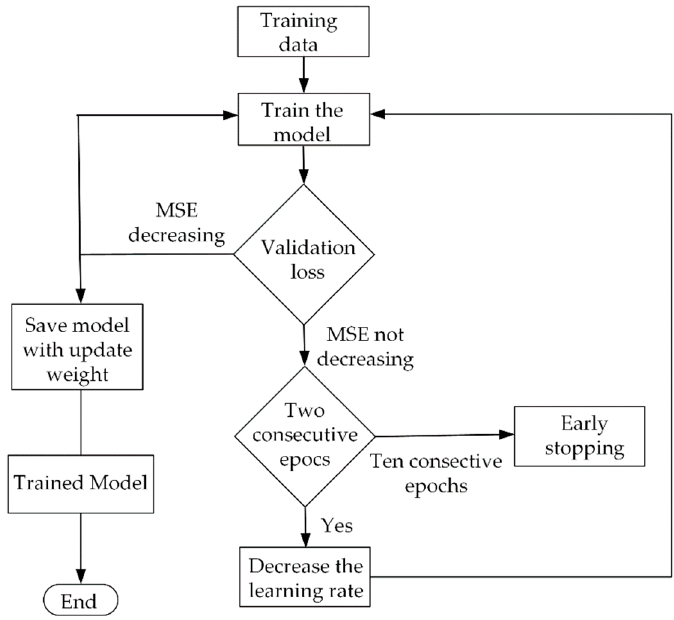
Figure 6. Training flow of proposed model.